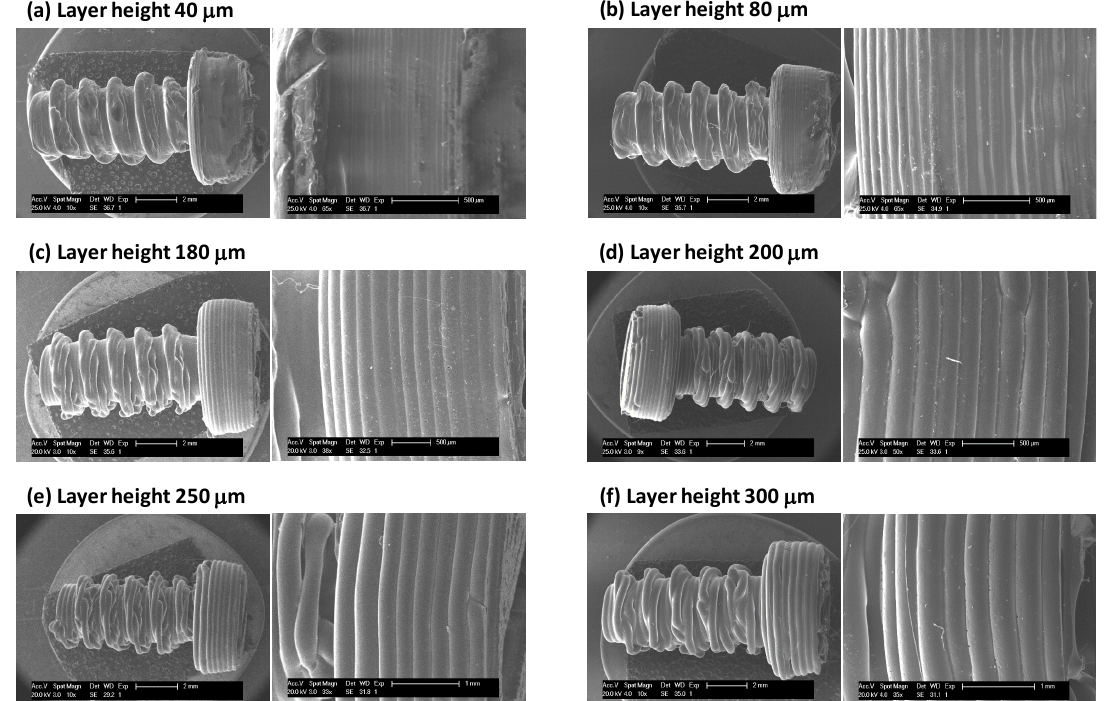
Figure 3. SEM images of the fused deposition modeling (FDM) fabricated of PCL screws with a variable layer height ranging from ( a ) 40 µ m, ( b ) 80 µ m, ( c ) 180 µ m, ( d ) 200 µ m, ( e ) 250 µ m and ( f ) 300 µ m.